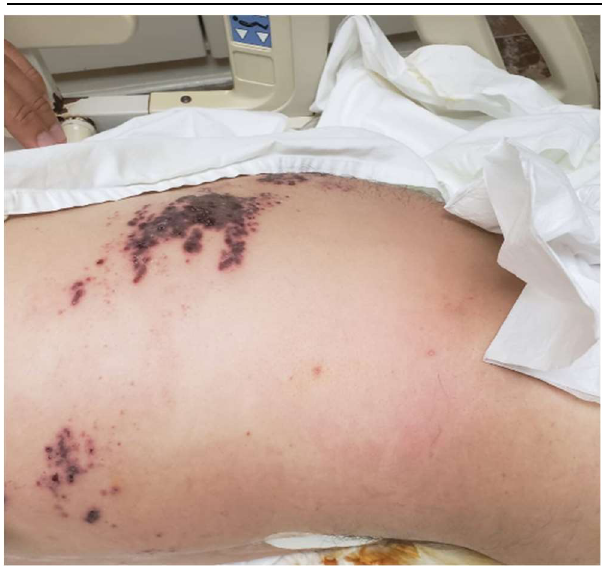
Figure 1 . Herpes-Zoster distribution .